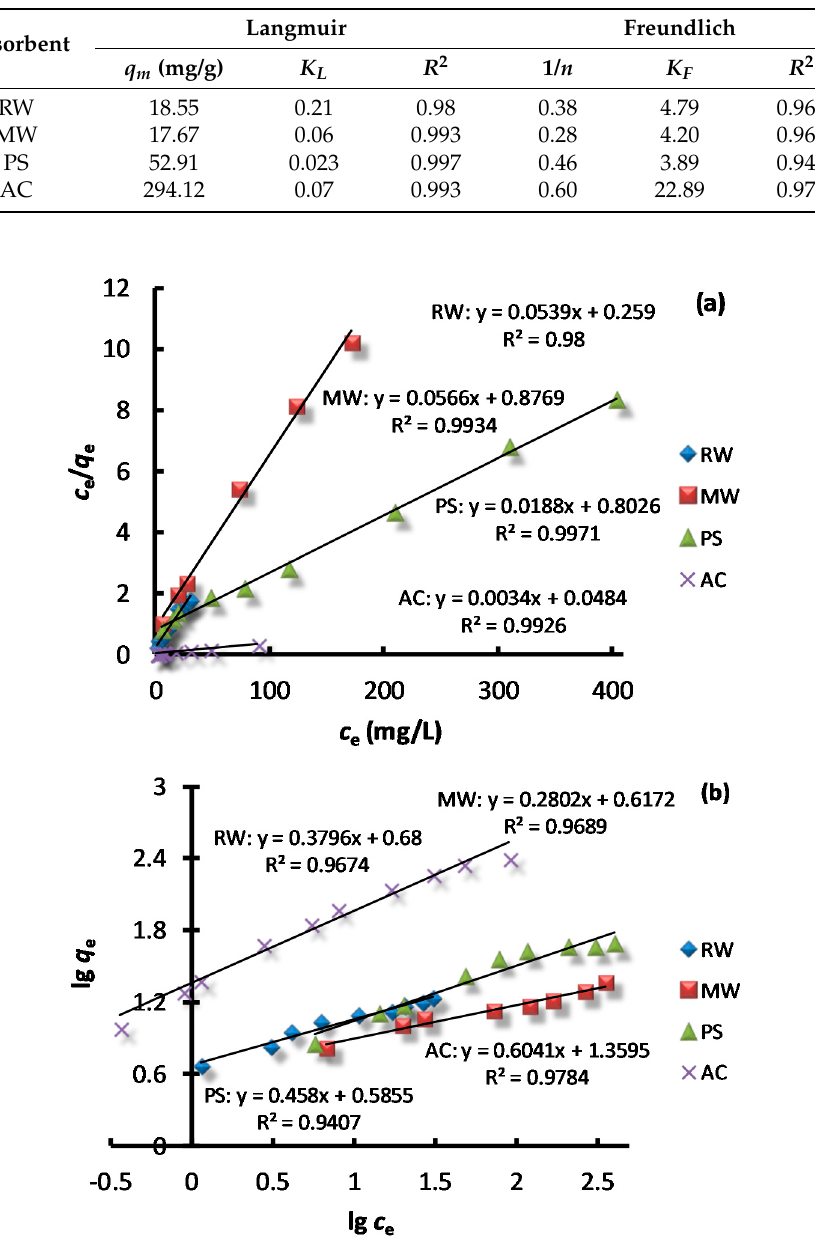
Figure 5. Langmuir ( a ) and Freundlich model ( b ) of adsorption.